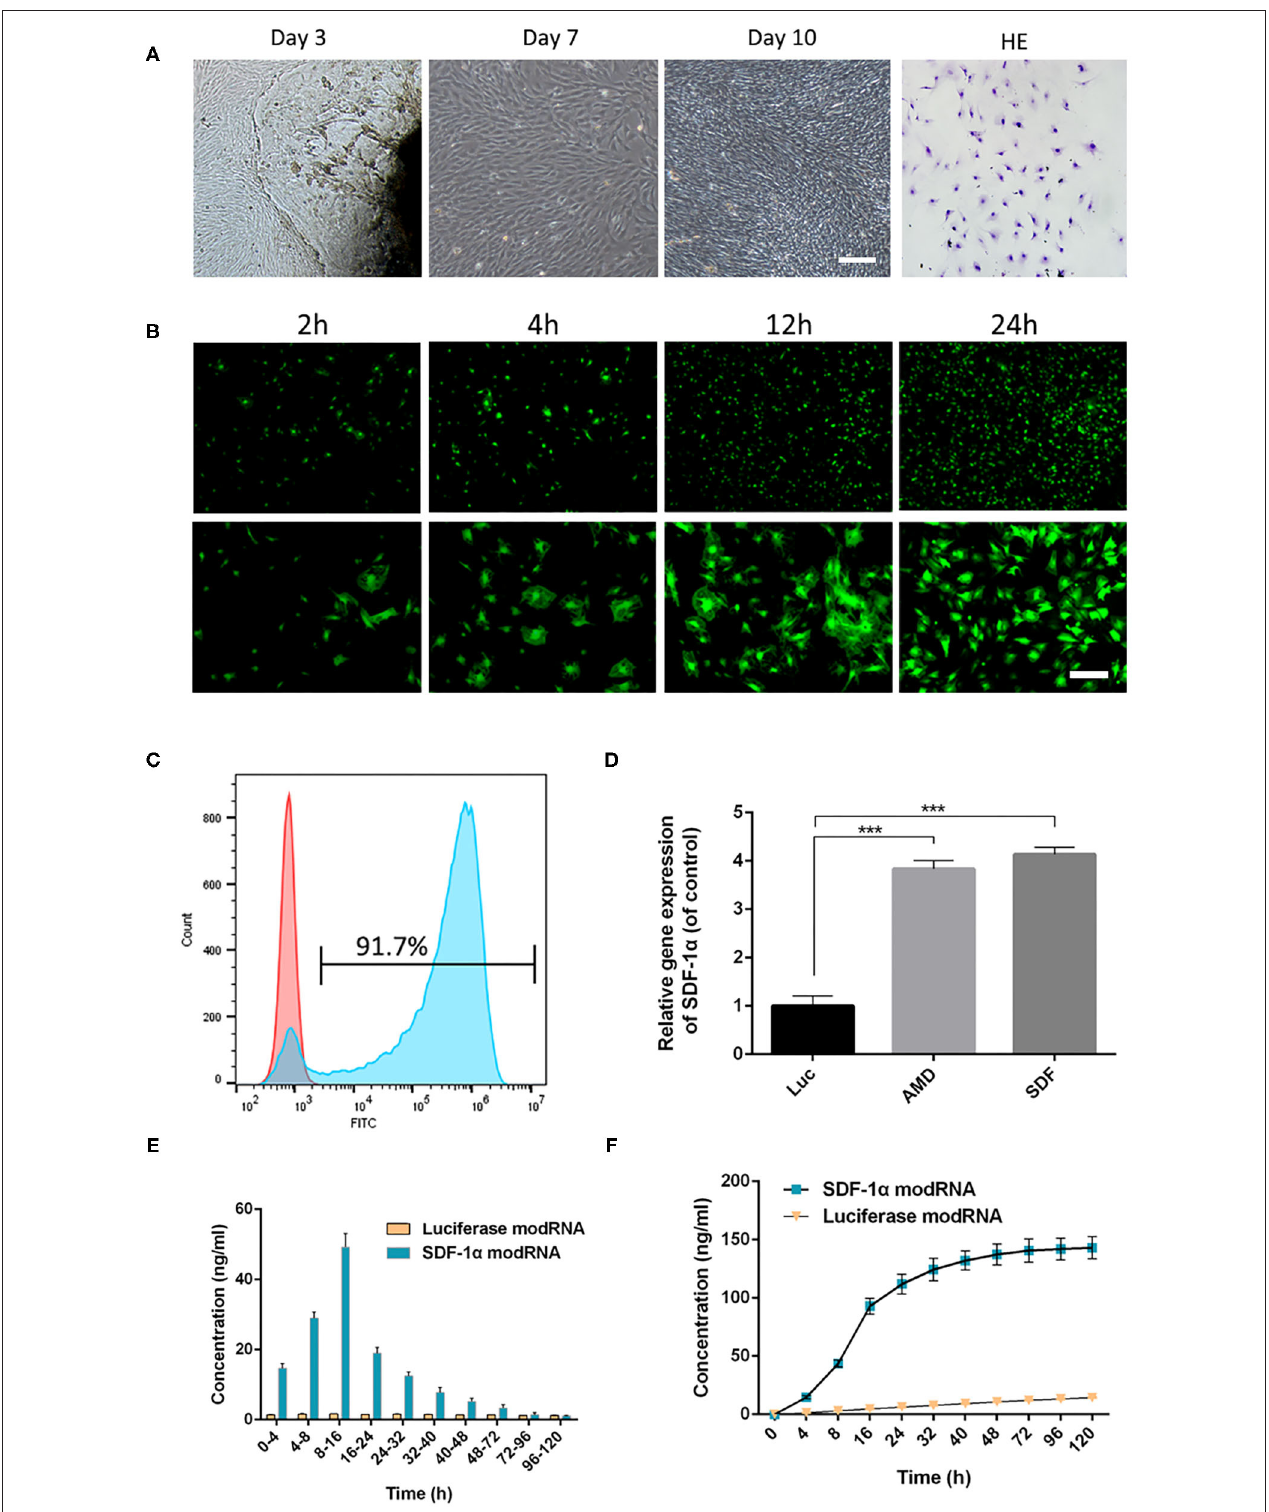
FIGURE 2 | Skin fibroblasts were cultured and transfected with modRNA. (A) The fibroblasts were observed under light microscope and identified by H&E staining (scale bar: 50 µ m). (B) Representative photo-micrographs depicting superior GFP signals in fibroblasts at 2, 4, 12, and 24h post-transfection (scale bar: 50 µ m).